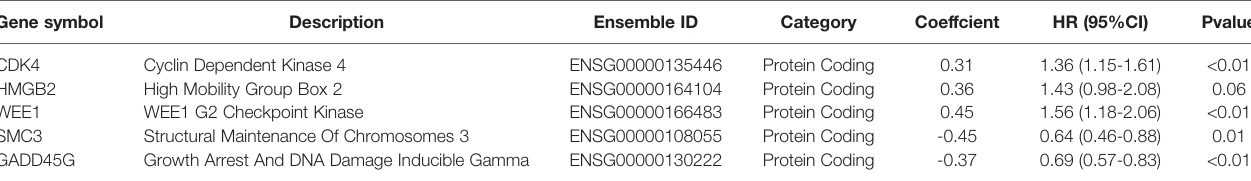
TABLE 2 | The information of 5 DNA repair genes constructing the prognostic risk